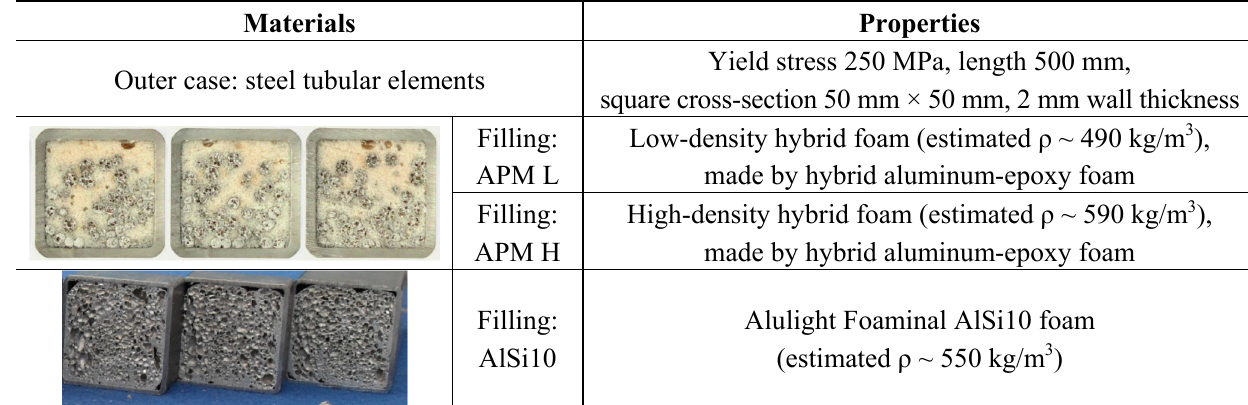
Table 1. Properties of foam-filled steel